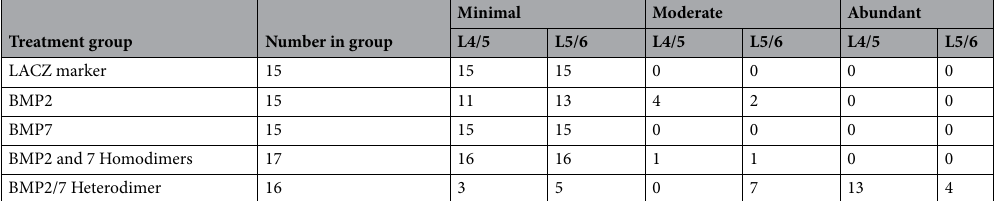
Table 5. Faxitron-assessed Bone Formation at Lumbar levels 4/5 (L4/5) and 5/6 (L5/6) at 12 Weeks Following Intradiscal Injection of Genetically Programmed Bone Marrow Stromal Cells. Bone formation was graded 0–2 by 3 observers as described in Materials and Methods, and summed score of 0–2 = Minimal, 3–4 = Moderate, and 5–6 = Abundant bone production.